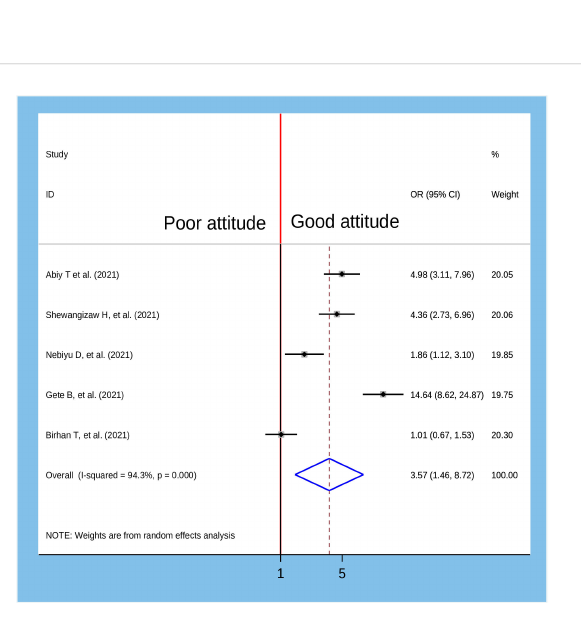
FIGURE 8 Association between age and willingness to accept COVID-19 vaccine in Ethiopia, 2022.